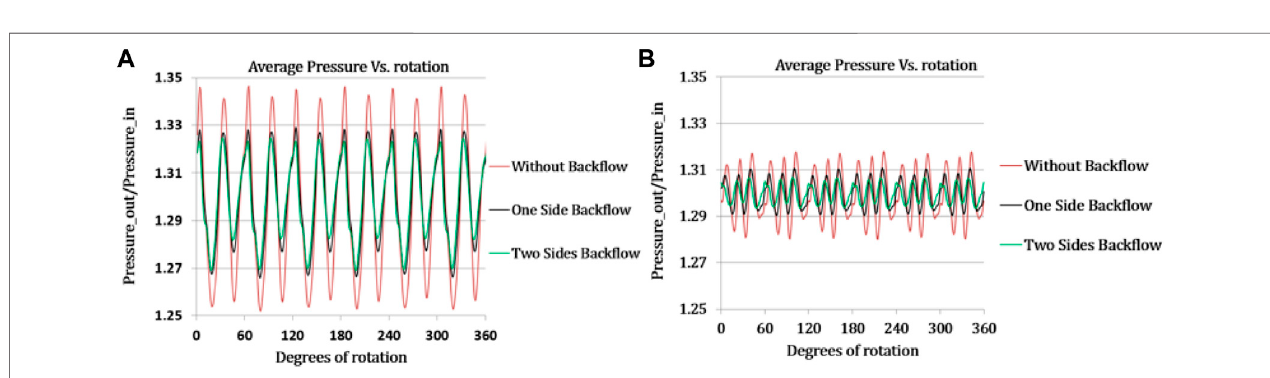
FIGURE 7 | Pressure pulsations for without back fl ow, one-side back fl ow, and two-side back fl ow port designs. (A) 10,000 rpm and PR-1.3. (B) 5,000 rpm and PR-1.3.